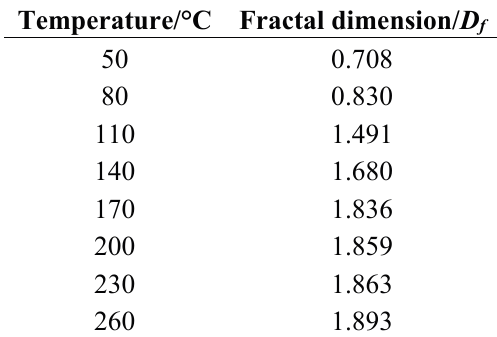
Table 2. Relational table of temperature and fractal dimension of the cracks on rock salt